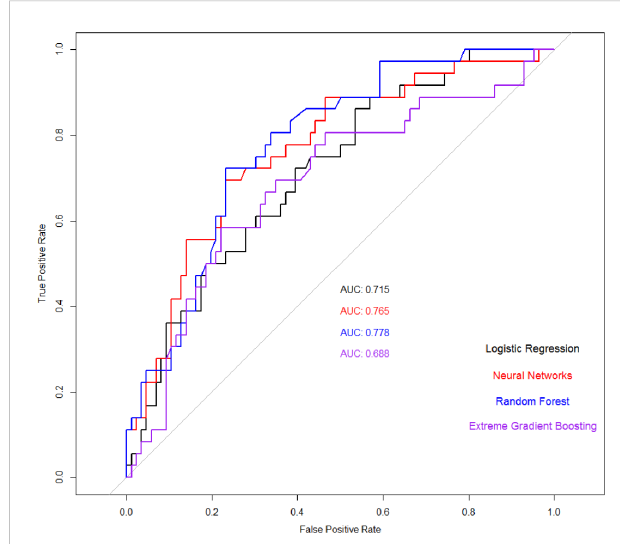
FIGURE 3 Receiver operating characteristic (ROC) curves of four applied machine learning (ML) models and the area under the curve (AUC) are speci fi ed for each